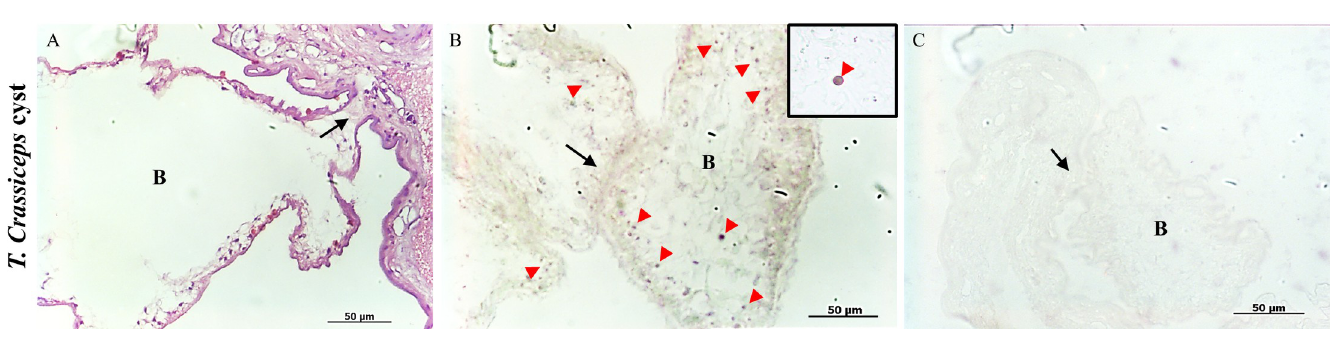
Fig 5. In situ identification of plk1 -expressing cells in samples of Taenia crassiceps cyst . HE staining (A) and ISH on Taenia crassiceps cyst (B) were also performed; positive cells were observed in the region of the "buds" formation (black arrows) and along the bladder wall of these structures (arrowheads). A higher magnification image is inserted. A sense probe (C) was used as a negative control. B: